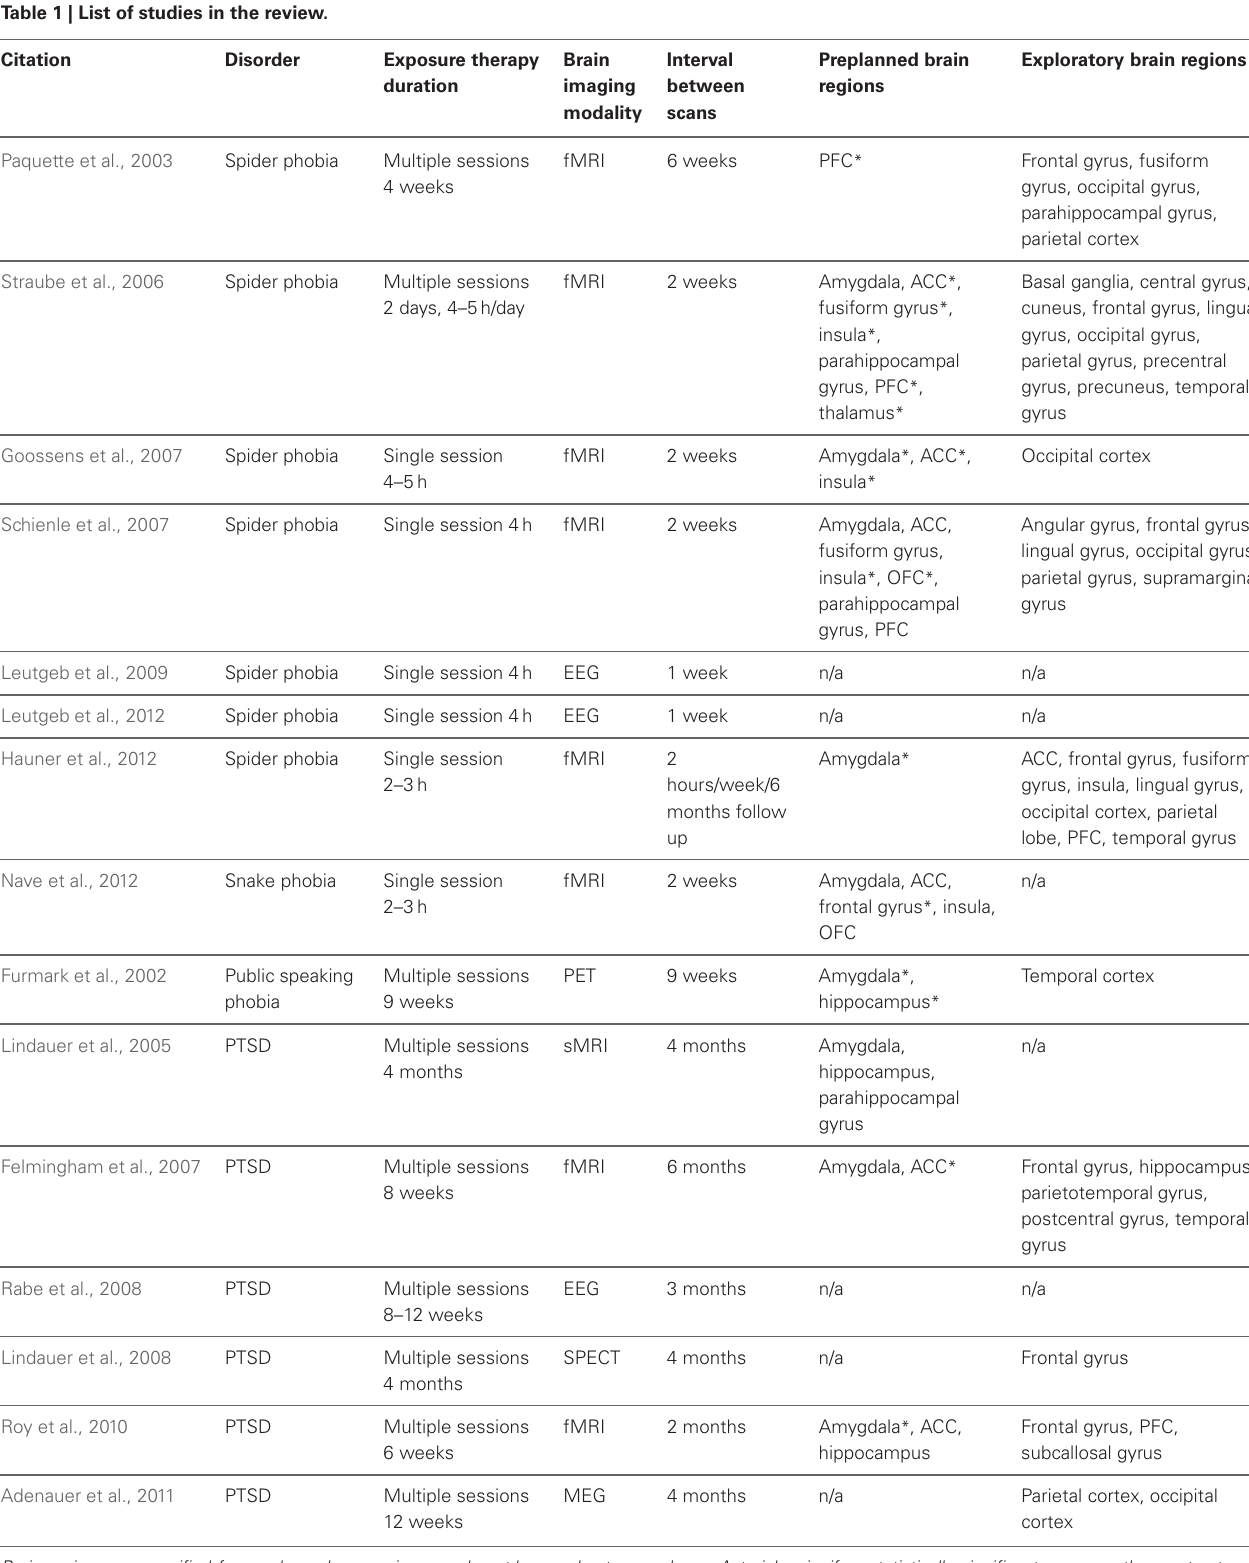
Table 1 | List of studies in the